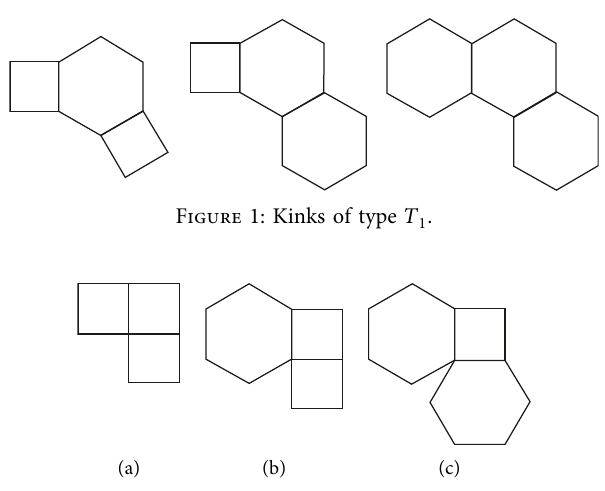
Figure 2: (a) Kinks of type T